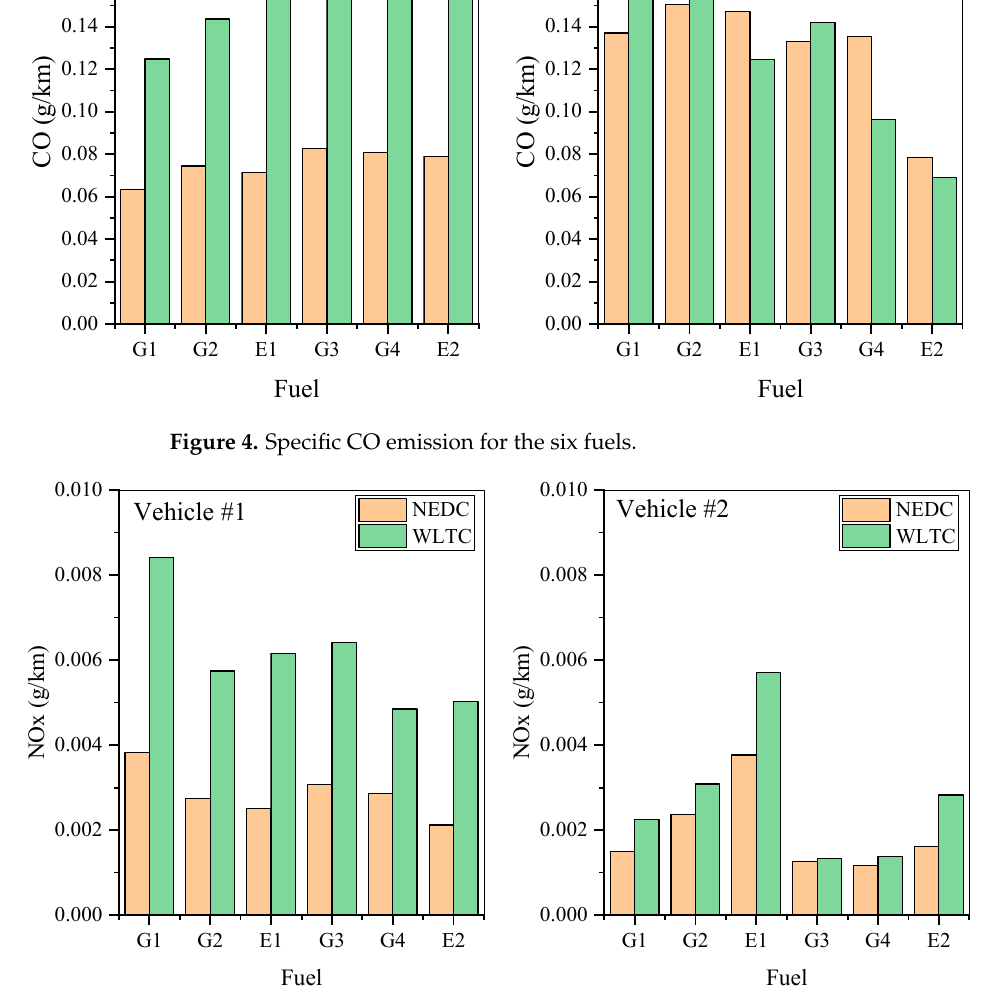
Figure 5. Specific NOx emission for the six fuels.